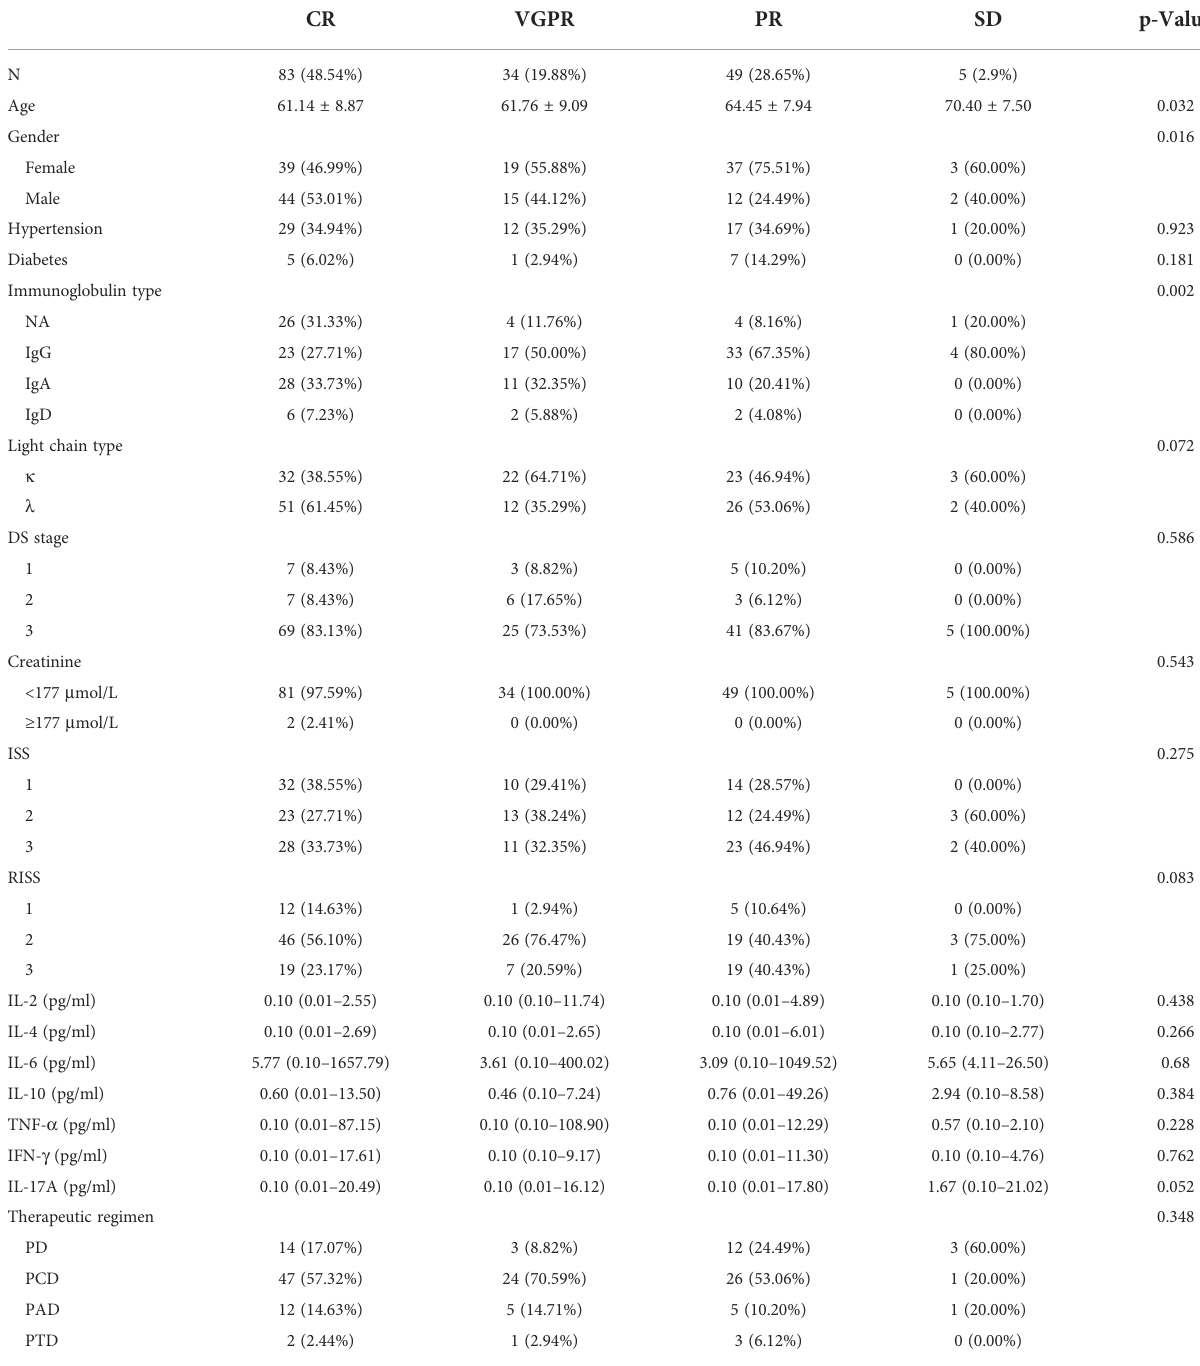
TABLE 3 Demographics of patients with MM in different ef fi